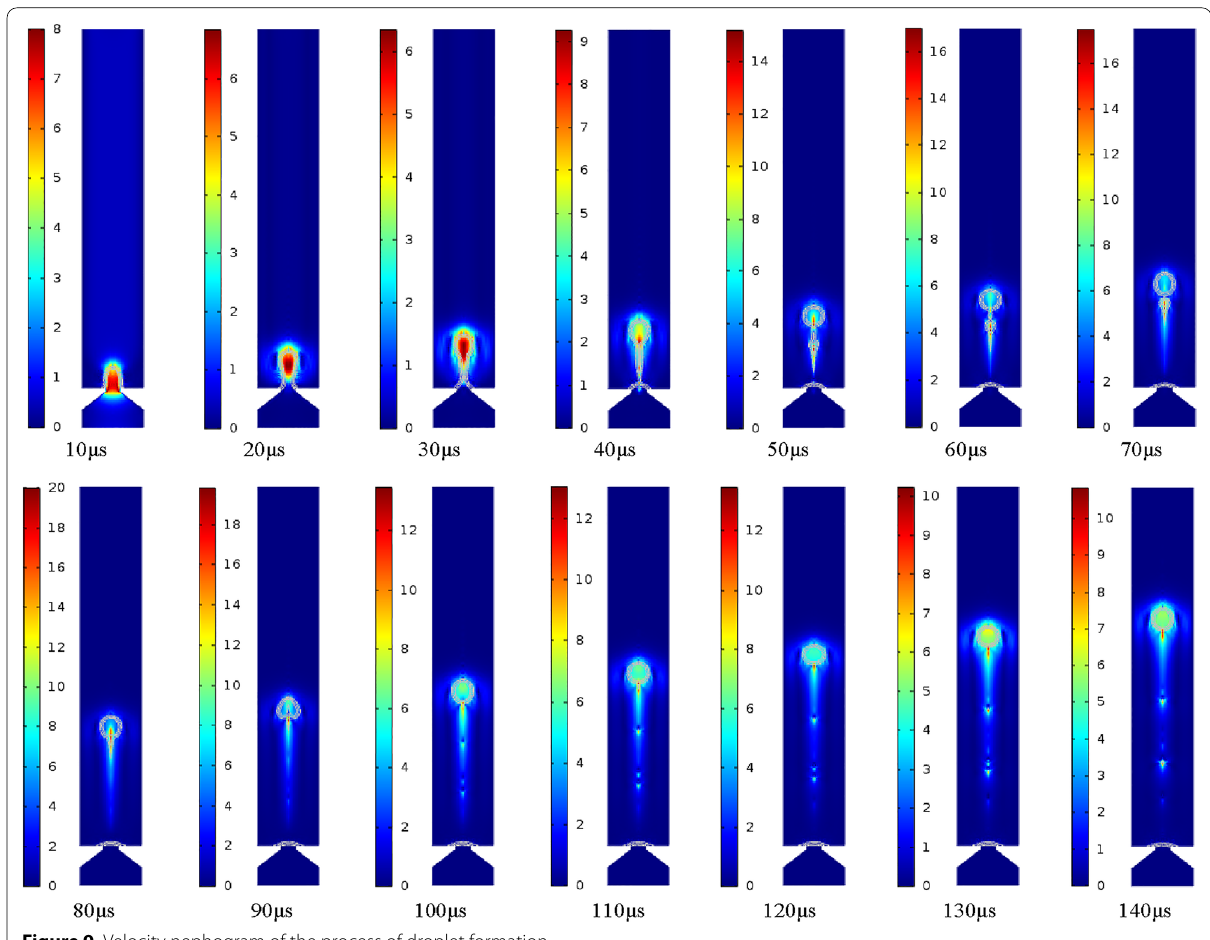
Figure 9 Velocity nephogram of the process of droplet